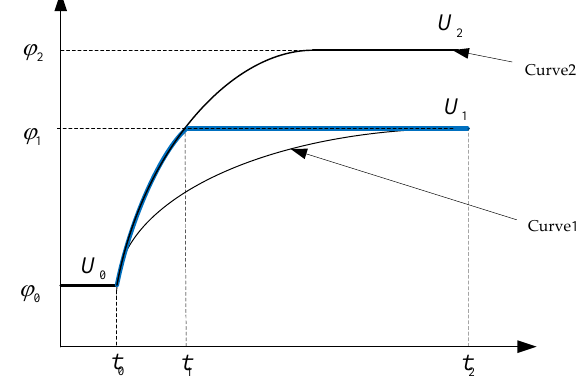
Figure 2. Schematic diagram of overdriving principle.